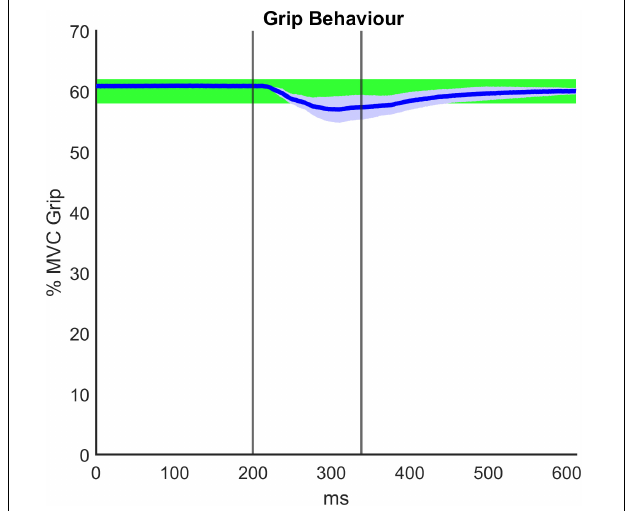
FIGURE 5 | Representative grip force data averaged among subjects and over time during the fast perturbation at 60% Grip, spanning from 200 ms pre perturbation to 300 ms after the end of the perturbation (130 ms). The graph displays the visual bar at 60% maximum voluntary contraction (MVC) Grip Force, as it was shown to the participants: the percentage of the required grip with its tolerance range ( ± 2%) is confined to the green area. The vertical lines identify the duration of the fast perturbations (specifically, 130